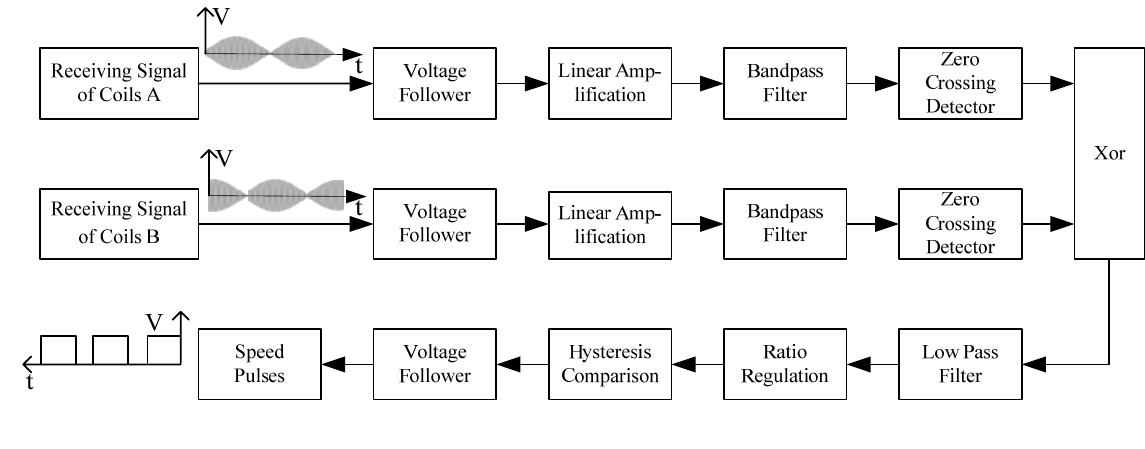
Figure 9. Structural drawing of signal processing.